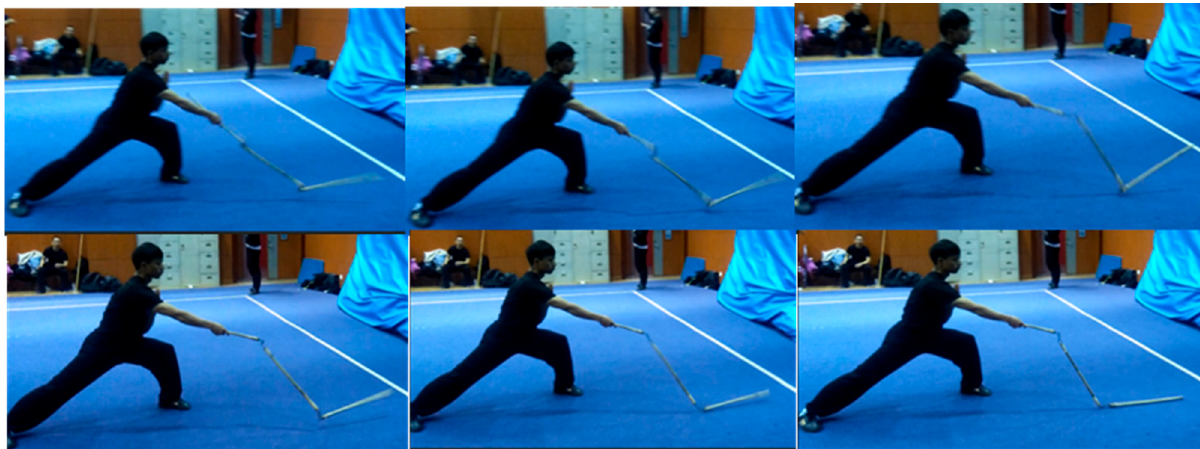
Figure 2. The process by which the cudgel bounces after being